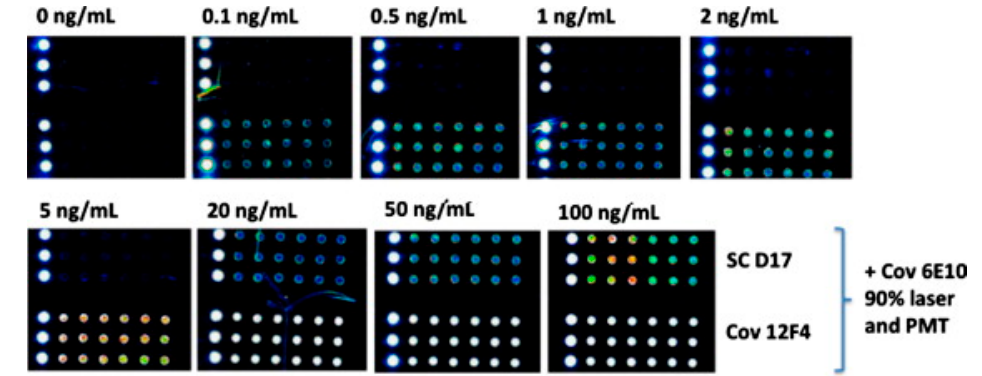
Figure 3. Fluorescence images for detecting A β 42 with concentrations from 0 to 100 ng / mL using SC-D17 (upper array) or Cov-12F4 (lower array) as the capture antibody and Cov-6E10 as the detection antibody. Reproduced from reference [75] with permission from